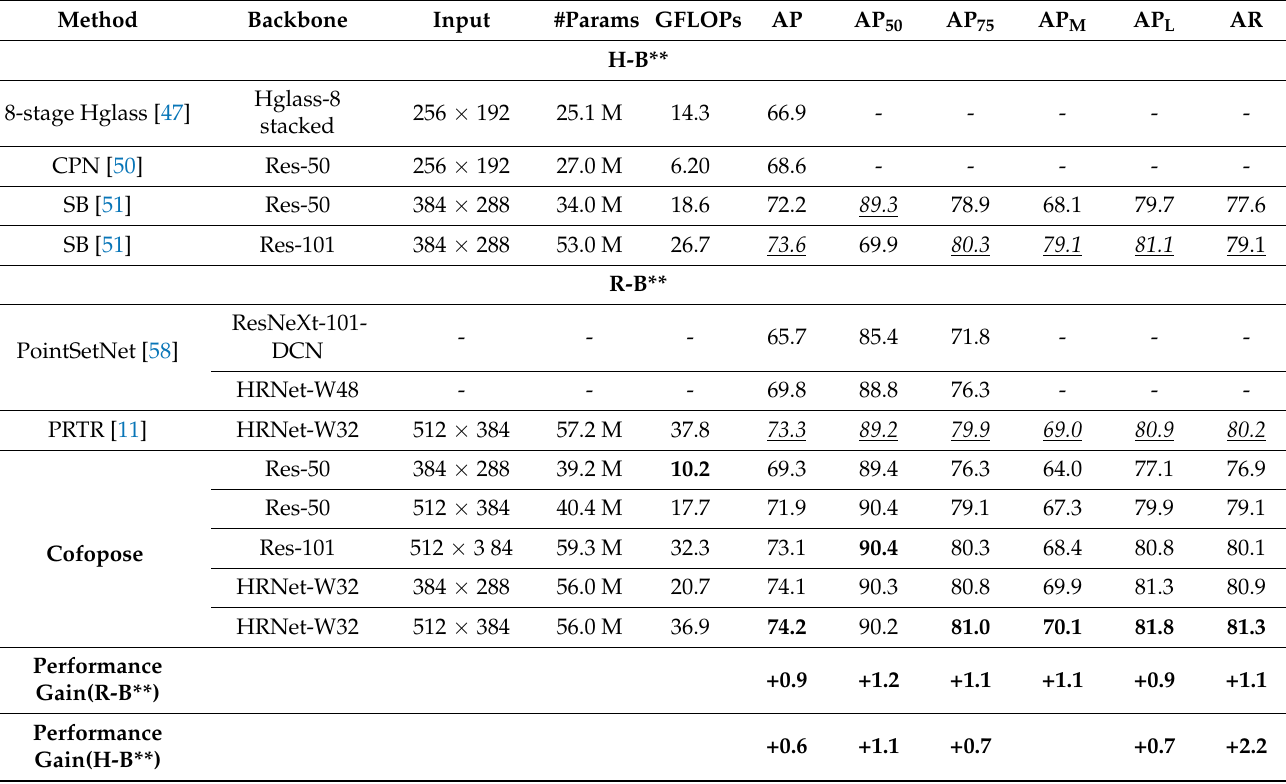
Table 3. Comparisons for the COCO val set. H-B** and R-B** represent the heatmap-based approach and the regression-based approach, respectively.